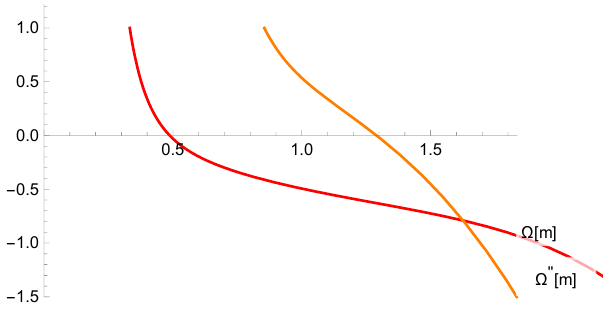
Figure 7 . The truncated asymptotic expansion of the grand potential Ω( m ) (red) and its second derivative Ω 00 ( m ) (orange) on the four-sphere.There is a flex for m ≈ 1 . 290 .